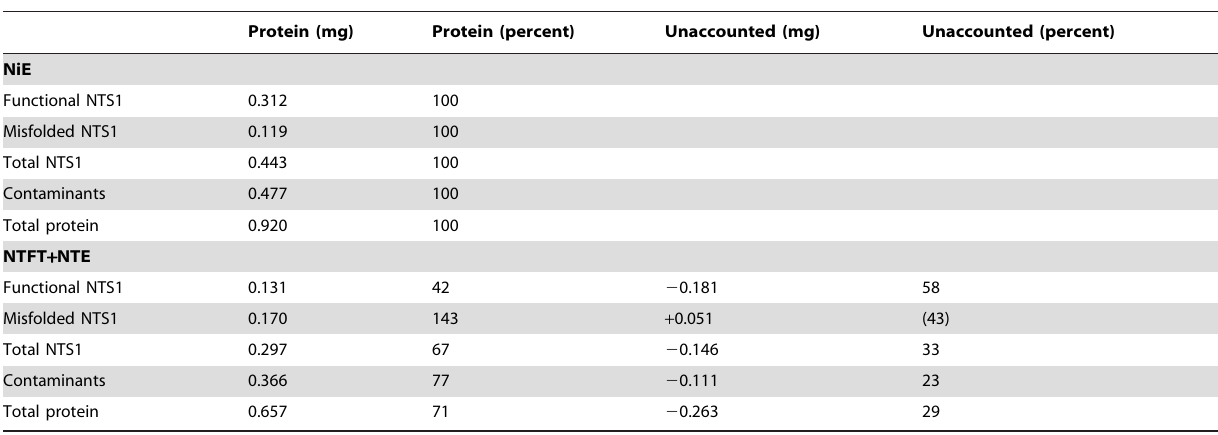
Table 5. Summary of NTS1